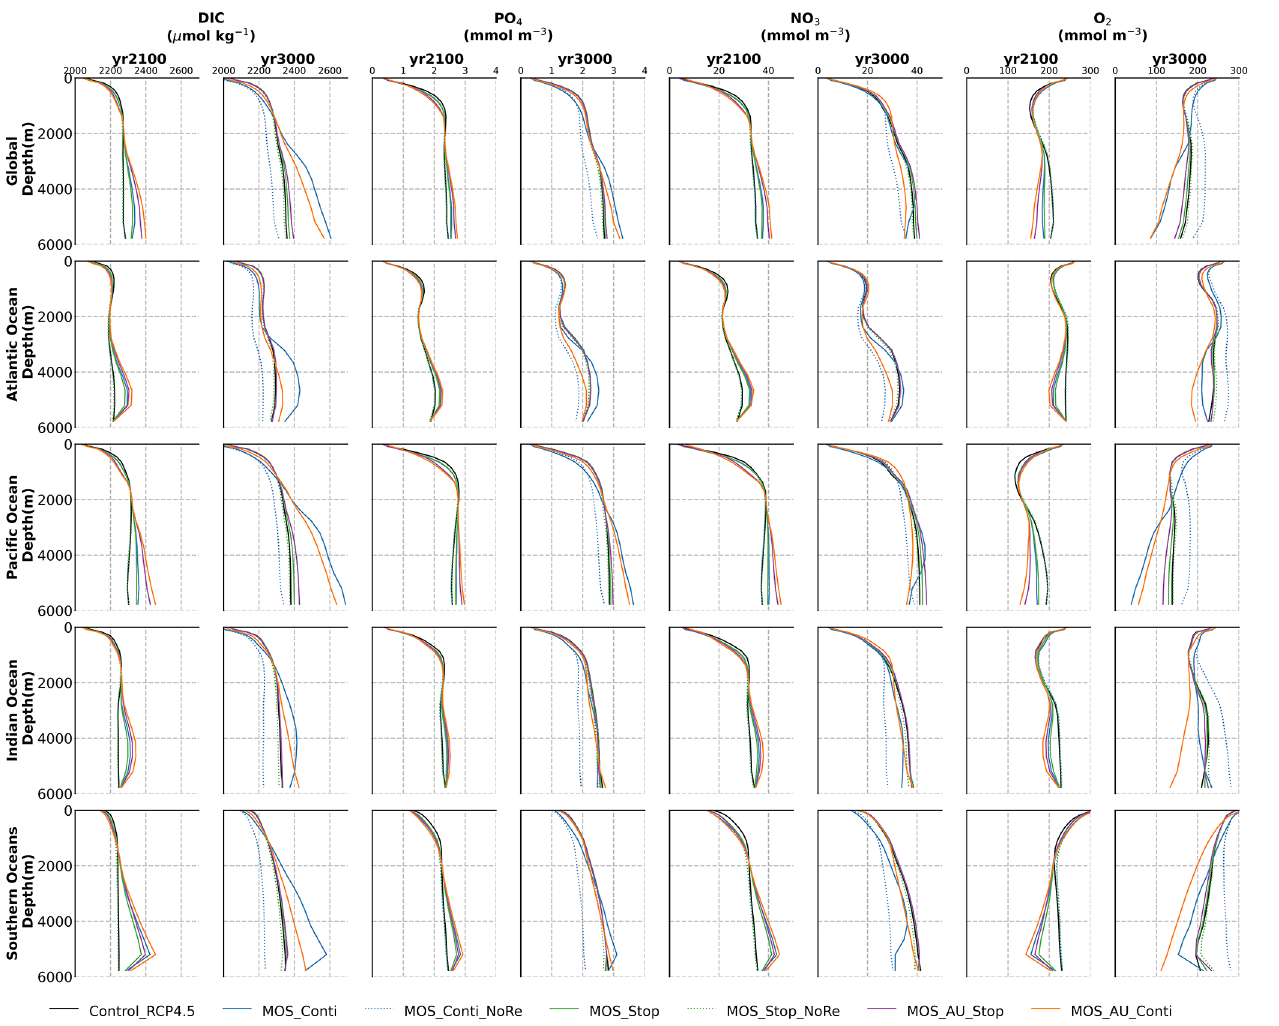
Figure 6. Global and basin-wide averaged vertical profiles of various model tracers in year 2100 and year 3000 under the RCP 4.5 emission scenario. In general, MOS (except for the zero-remineralization one) transports DIC and nutrients in the surface layer to the deep ocean. The oxygen levels are increased in the mid layers due to the declined downward organic-particle flux (Sect. 4.3.4), but they are decreased in the deep ocean as a result of the remineralization of sunken biomass. These impacts are strengthened when MOS is deployed continuously and/or in conjunction with